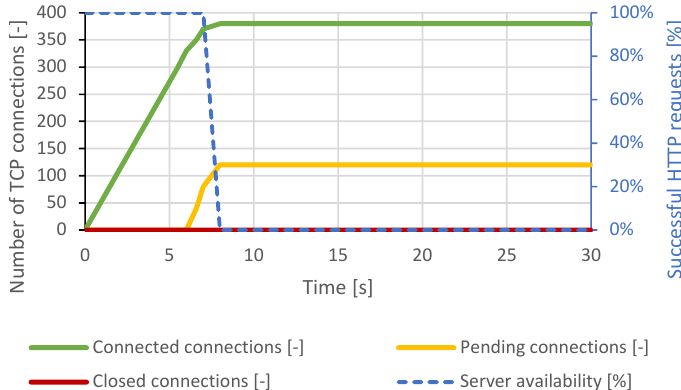
Figure 8. SlowDrop attack against Apache server.